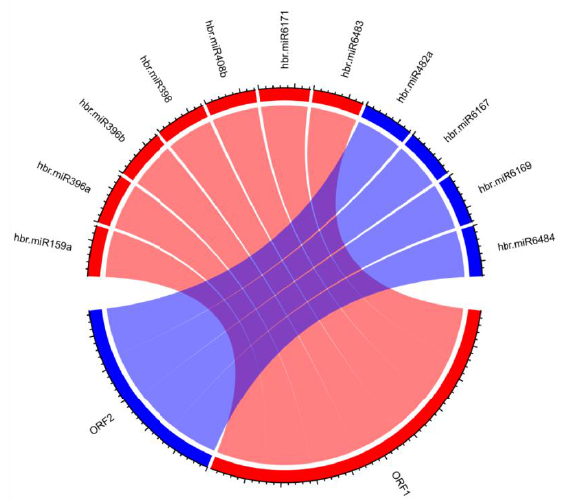
Figure 5. A schematic interaction Circos map representing the rubber tree miRNAs and RTV1 ORFs. The colored lines represent the RTV1 genomic components